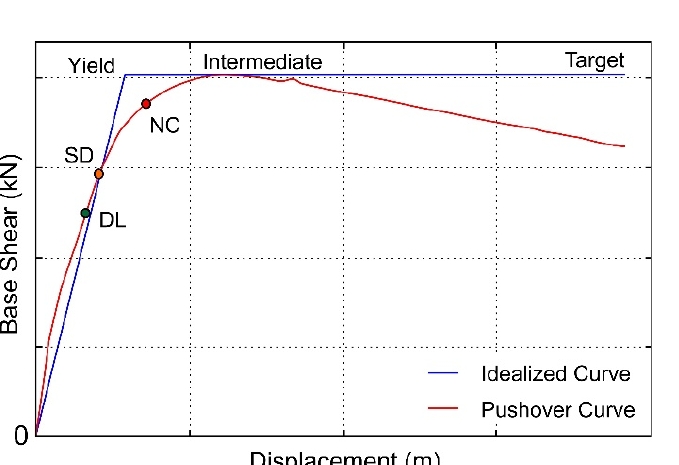
Figure 11. Typical pushover and idealized curves and calculated displacements.